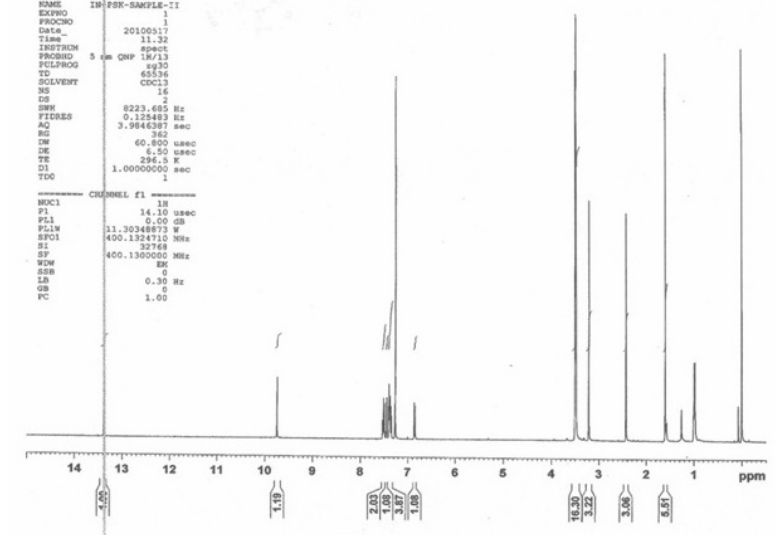
Figure 1. 1 H NMR spectra of 5Br SALAAP